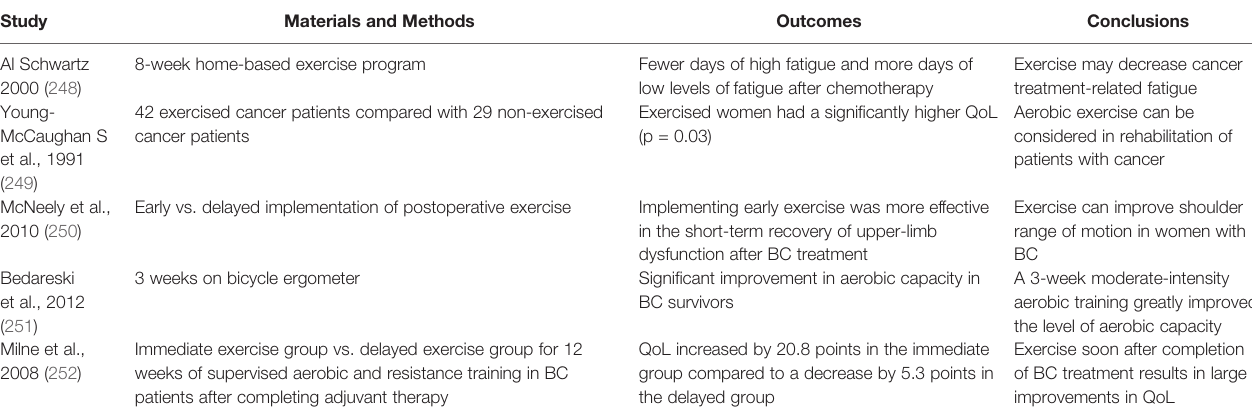
TABLE 3 | Effects of physical exercise on BC treatment outcome.